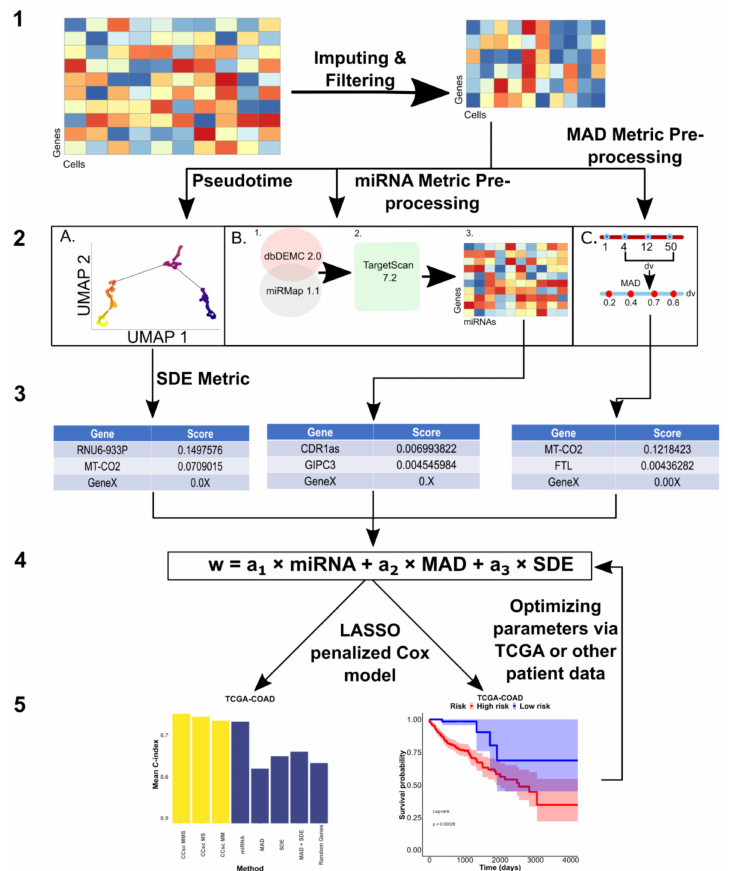
Figure 1. Overall Design of CCsc. CCsc is composed of 5 steps. ( 1 ) Obtaining pre-processed scRNA- seq matrix (genes by cells) and performing imputation and denoising via the MAGIC package and then filtering for low abundance samples. ( 2 ) Using filtered, denoised, and imputed scRNA-seq matrix to perform metric dependent pre-processing steps. ( A ) For the SDE metric this involves ordering the scRNA-seq matrix by pseudotime based on the expression of the VIM marker. ( B ) For the miRNA metric, this involves sending the matrix to our novel miRNA metric. ( C ) We calculate the MAD metric from the scRNA-seq matrix. ( 3 ) In this step, we generate a distinct gene list from each of our three metrics. ( 4 ) We integrated and merged the three separate gene lists into a single master list based on their score. From this master list, we then send N number of genes from the list as inputs to a LASSO penalized Cox model. The metric weights (a1, a2 and a3) are optimized via a grid search that involves the next step. ( 5 ) This step yields the outputs of our penalized Cox model that uses concordance index to assess our model’s accuracy. We also generate Kaplan–Meier survival curves, based on the model output, to further validate the efficacy of the genes selected by our model. Based on the Cox model outputs, we can optimize the gene weights of our linear model to achieve the best